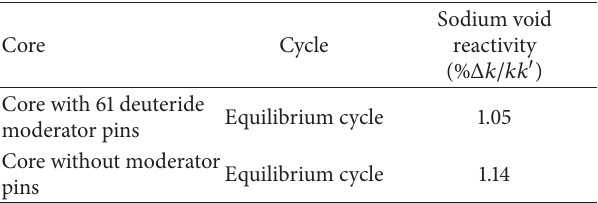
Table 6: Comparison of sodium void reactivity between cores with and without